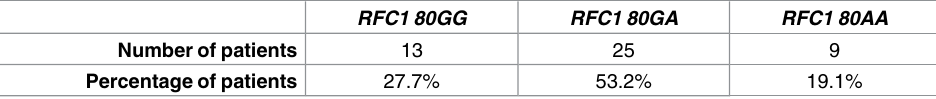
Table 2. RFC1 80G > Agenotypes frequencies in primary liver cancer patients (n =